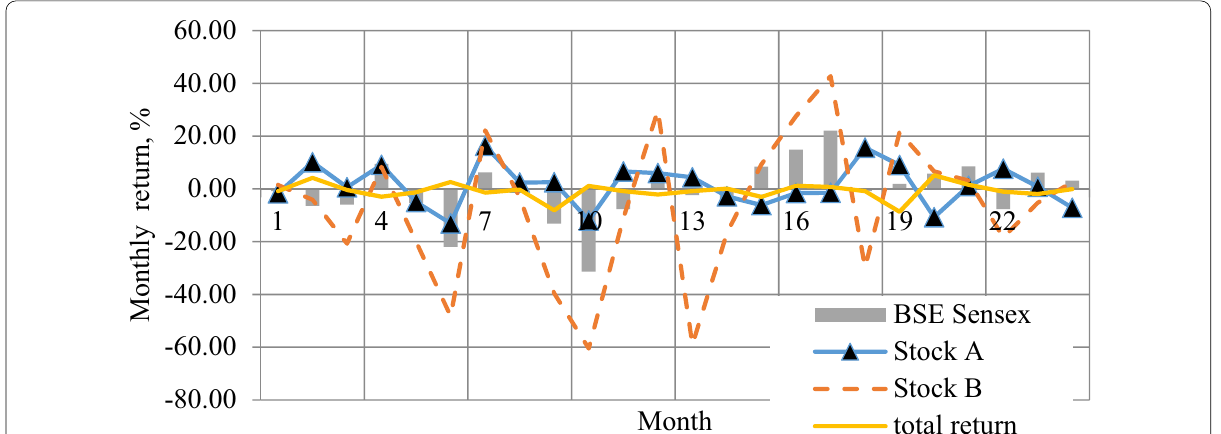
Fig. 18 Monthly returns for stocks A and B and total return for stock A compared to return from BSE